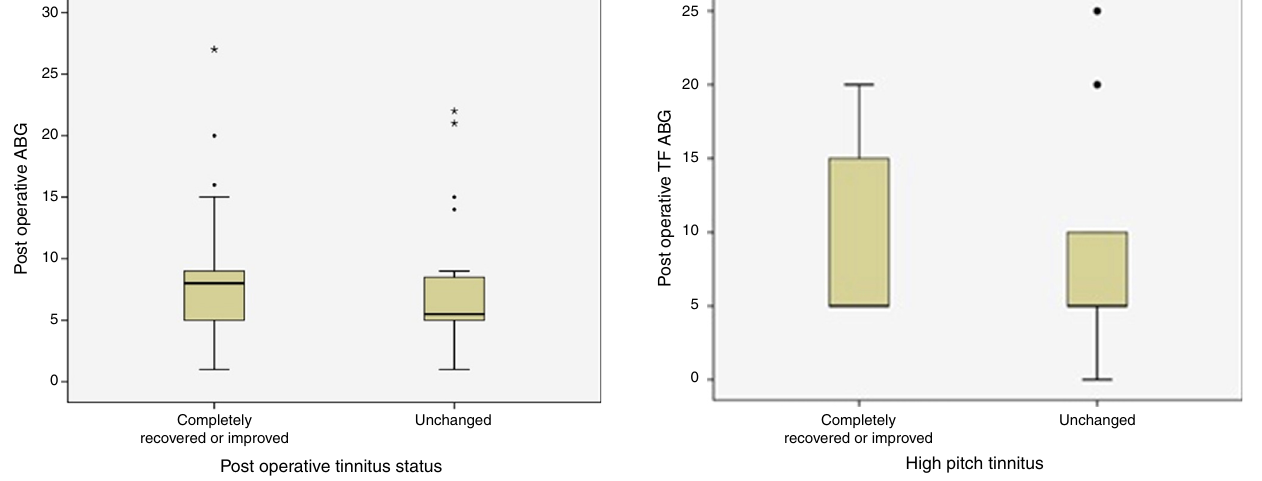
Figure 1 Comparison of postoperative tinnitus status and postoperative average pure tone threshold ABG levels has been demonstrated (ABG, Air-Bone Gap).